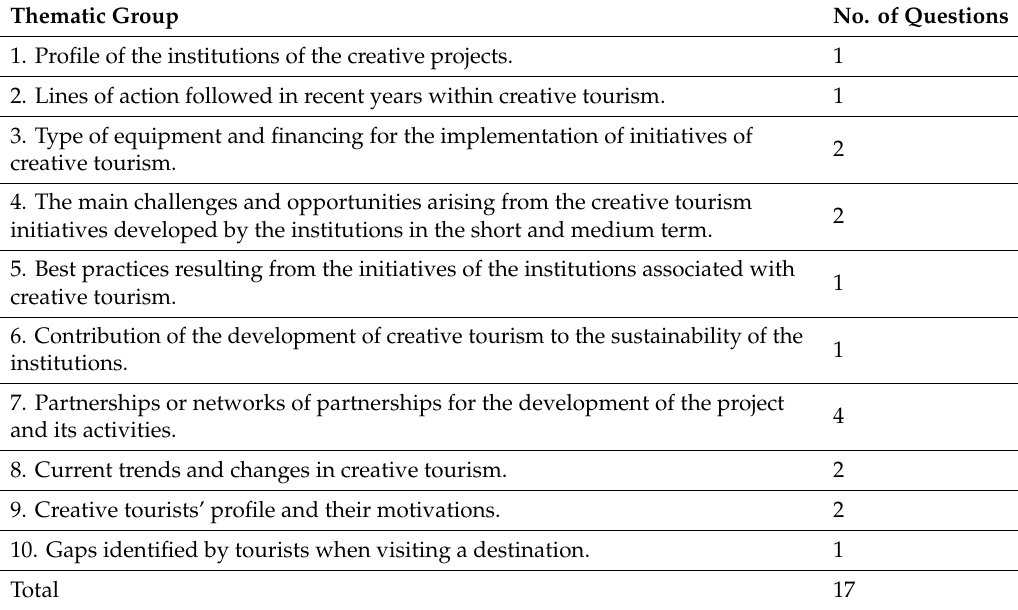
Table 1. Thematic groups and the number of questions used in the interview guide for managers of creative tourism ‘platform’